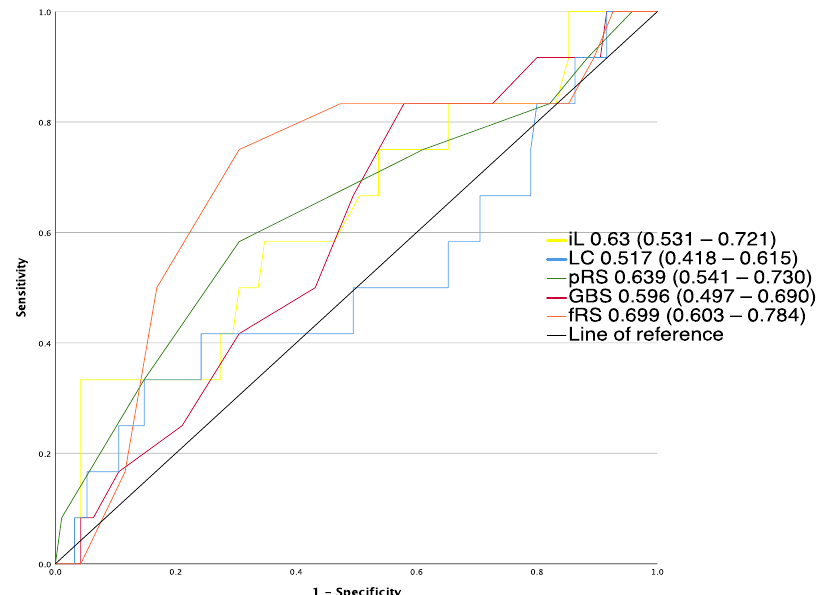
Figure 2. AUROCs of risk assessment tools for the prediction of 30-day mortality fRS, full Rockall score; GBS, Glasgow–Blatchford score; iL, initial lactate; LC, lactate clearance; p-RS, pre-endoscopic